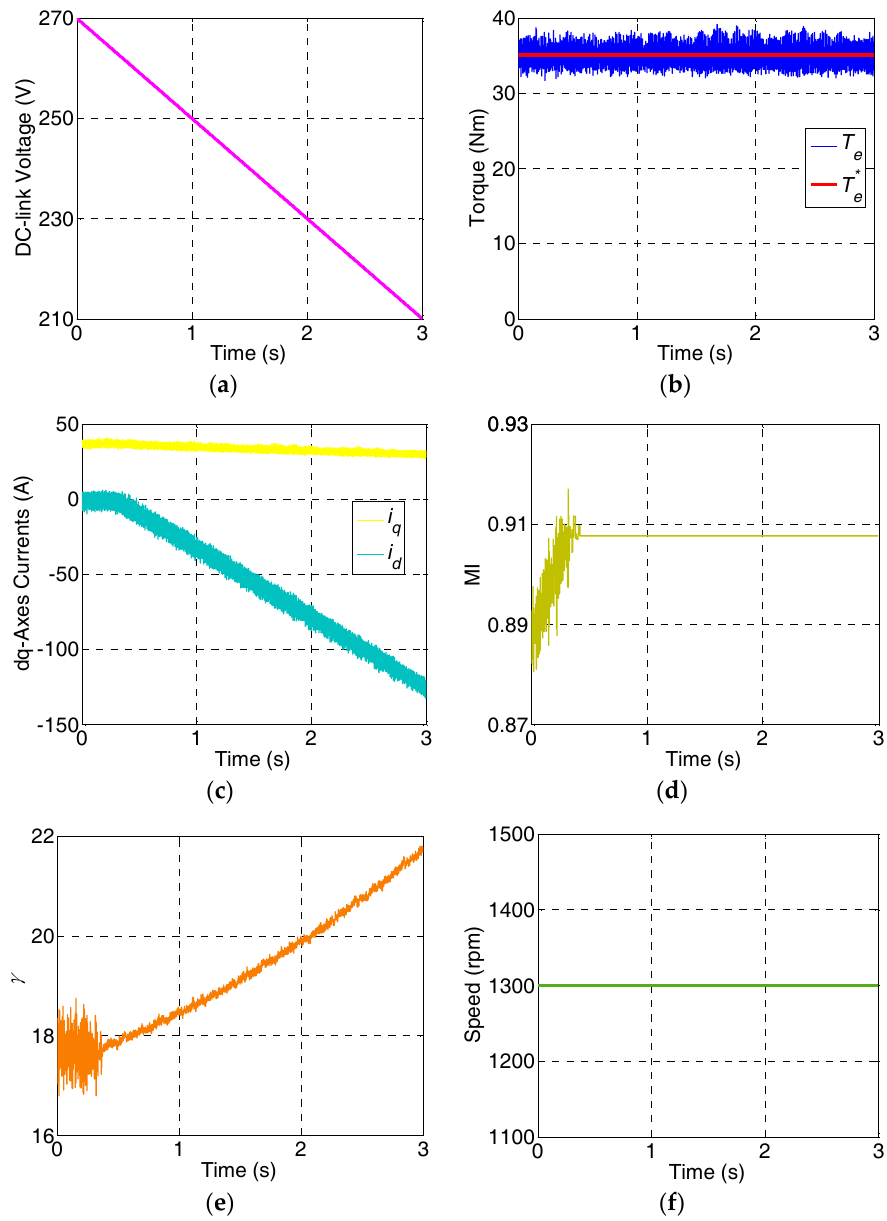
Figure 5. Simulation results under an adjustable DC-link voltage. ( a ) DC-link voltage; ( b ) Torque; ( c ) dq Axes-Currents; ( d ) Modulation Index (MI); ( e ) γ ; ( f ) Speed.